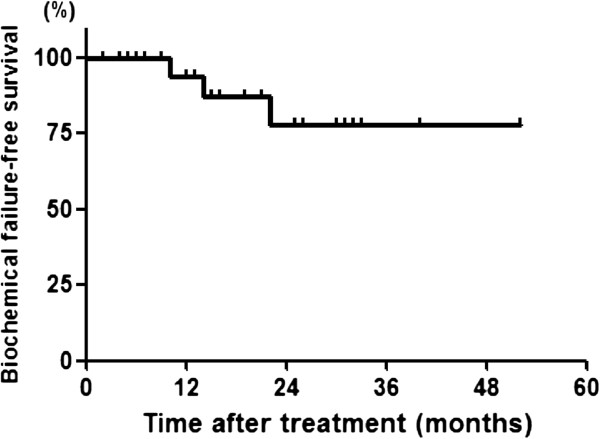
Biochemical disease free-survival of 26 patients treated with focal cryoablation of the prostate.